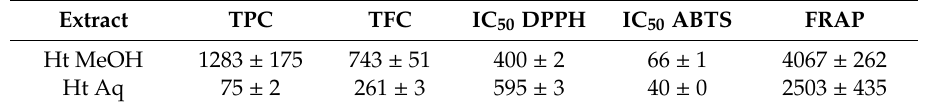
Table 1. Total phenolic content (TPC), total flavonoids content (TFC), DPPH, ABTS, and FRAP (ferric reducing-antioxidant power) were used to evaluate the methanolic (Ht MeOH) and aqueous extract (Ht Aq) of H. taltalense